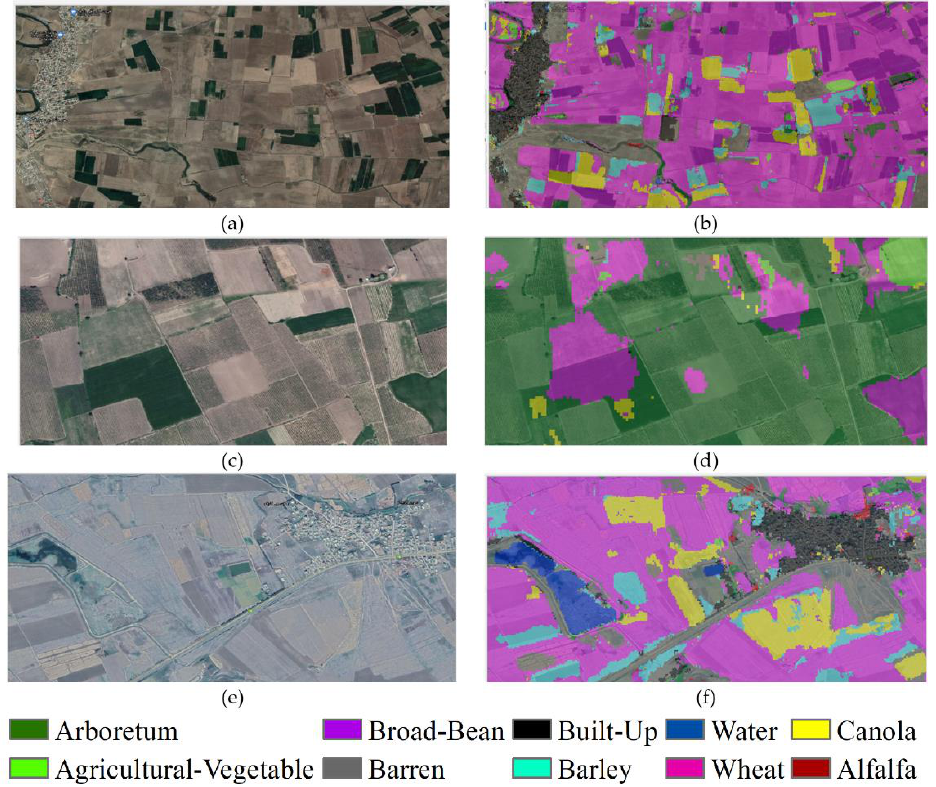
Figure 11. Comparison of the results of crop mapping ( b , d , f ) using the proposed method with very high resolution (VHR) imagery ( a , c , e ) in different areas. The left column is VHR imagery, and the right column is classified maps with the background of the VHR imagery.